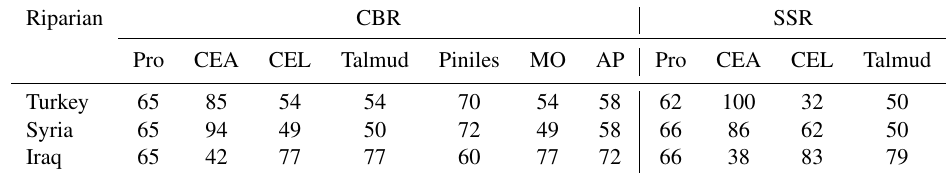
Table 3. Priority vectors, Priority Index and ranking of eleven CBR and SSR